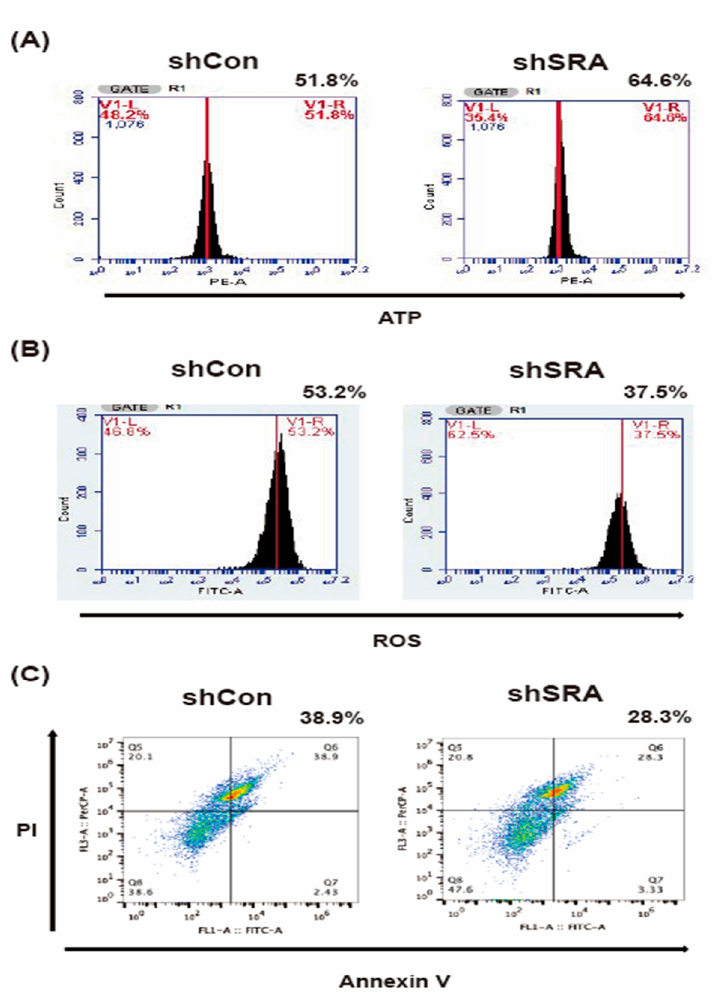
Figure 5. lncRNA SRA silencing induces ATP production, represses reactive oxygen species (ROS) levels, and inhibits MIN6 β -cell apoptosis. Representative flow cytometric analysis for ( A ) ATP production, ( B ) ROS induction, ( C ) and apoptotic markers by annexin V and propidium iodide (PI) staining in MIN6 β -cells after knockdown lncRNA SRA (shCon and shSRA). Mean ± SD, Student’s t -test (unpaired,